Question: Produce a descriptive caption suitable for publication.
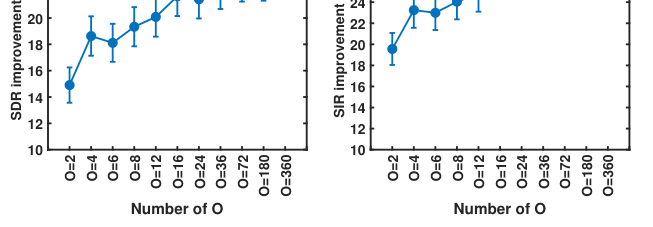
Answer: Average SDR and SIR improvements versus the value of O. Conditions: source signals are from two female speakers in WSJ0 and there is no reverberation.